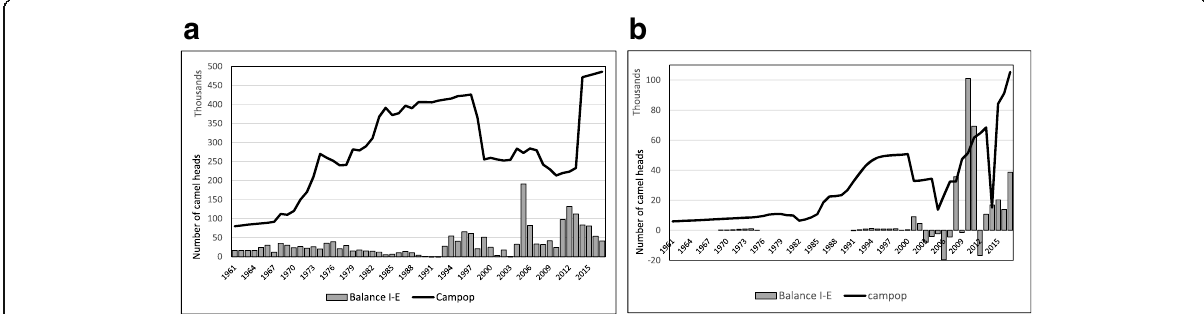
Fig. 11 Camel demographic pattern in Saudi-Arabia ( a ) and Qatar ( b ) for the period 1961 – 2018 and balance of import-export live camels